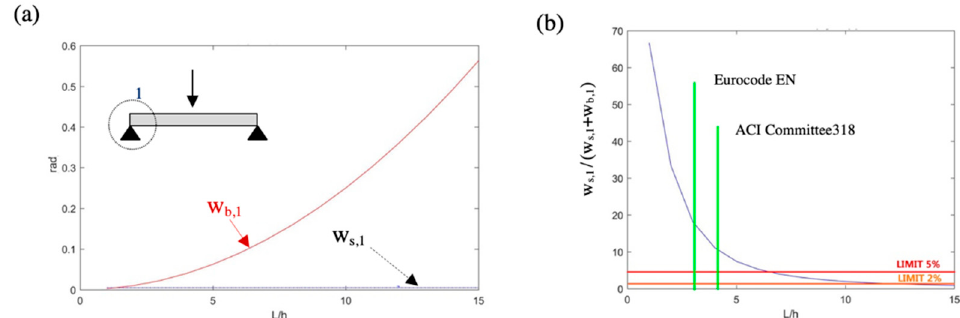
Figure 6. Parametric analysis of the slenderness ratio on example 1: ( a ) bending ( w b ,1 ) and shear ( w s ,1 ) rotations at node 1 and ( b ) percentage error of rotations in node 1 when ws,1 was neglected.